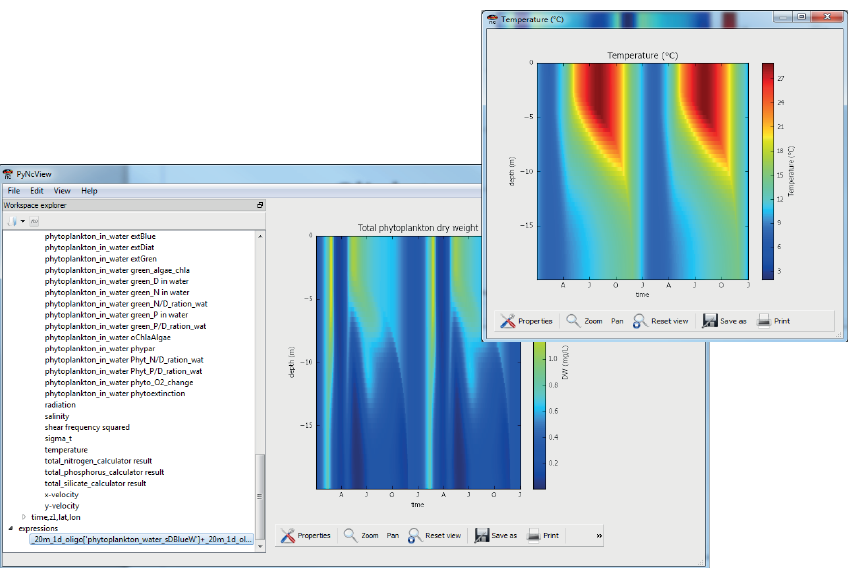
Figure 4. Visualization of FABM-PCLake state variables in PyNcView, exemplified by a 2-year period simulated by a one-dimensional FABM-PCLake application of a 20m deep water column. Variables to be viewed are simply selected in the left panel, and figures can be viewed, manipulated and saved in the right panel and as detached figures (a detached figure is exemplified by the temperature plot).